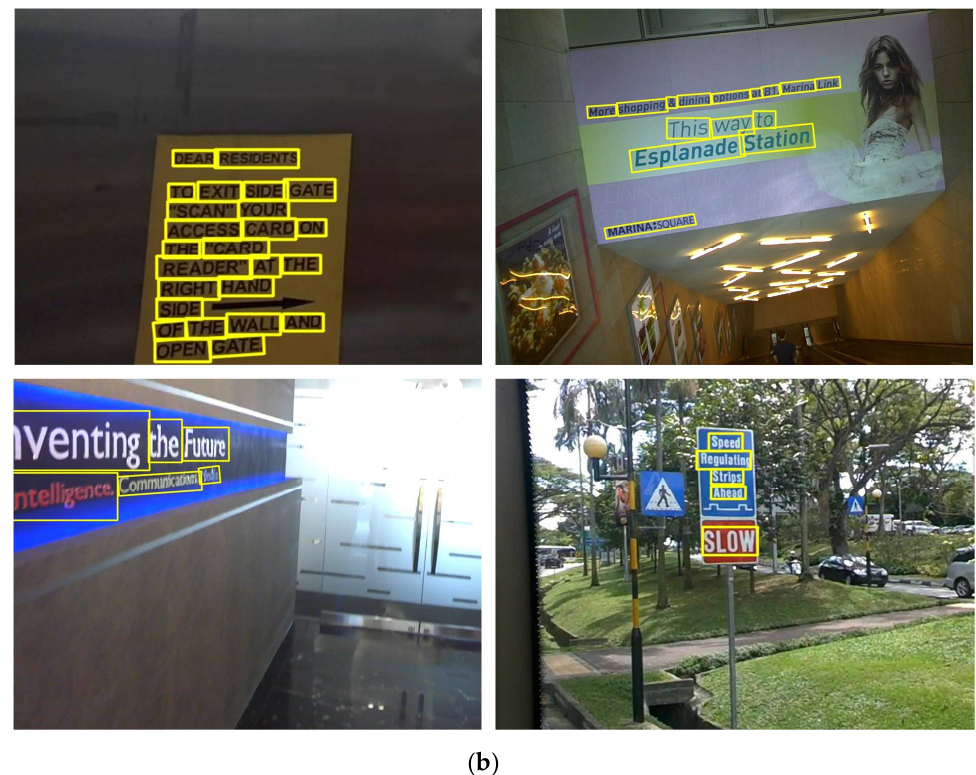
Figure 7. Comparison of detection results. Contains three sets of pictures, respectively, “Ours-I”, “Ours” detection effect chart. ( a ) The detection effect chart of “Ours-I”, ( b ) the detection effect chart of “Ours”.